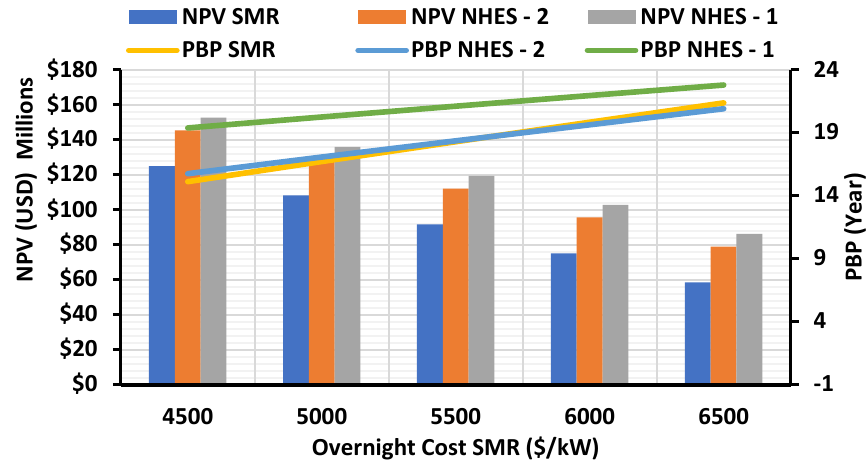
Figure 16. NPV and PBP vs. overnight cost of advanced SMR for Southwest region.